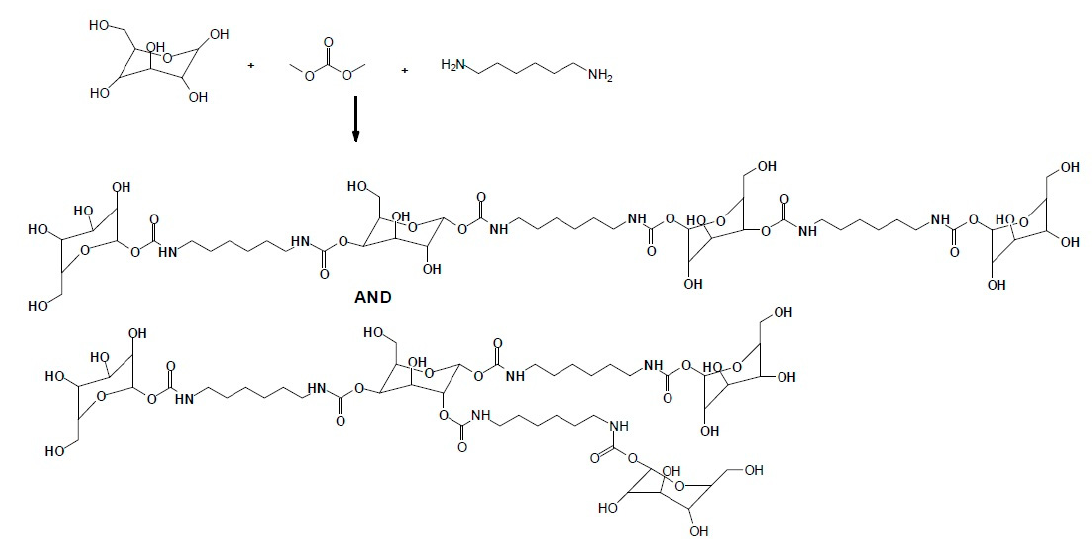
Figure 3. Schematic representation of the formation of non-isocyanate polyurethane (NIPU) oligomers from monosaccharides reacted with dimethyl carbonate and hexamethylene diamine. The two tetramers shown have been identified and are among the multitude of other NIPU oligomers identified [110].